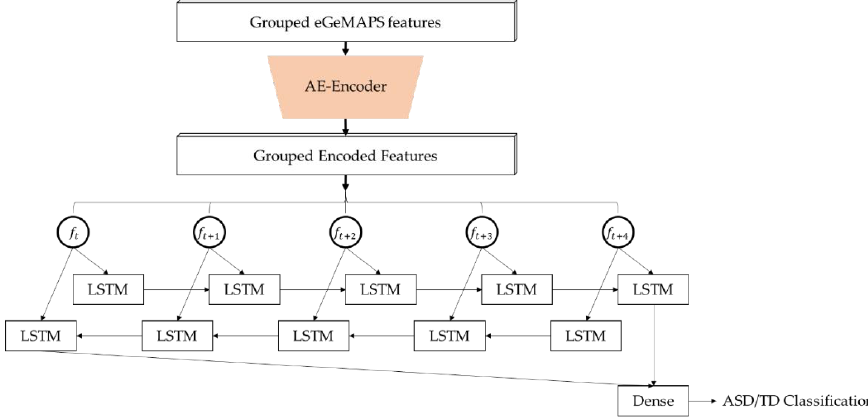
Figure 2. Structure of a joint optimization model of an auto-encoder (AE) and bidirectional long short-term memory (BLSTM).